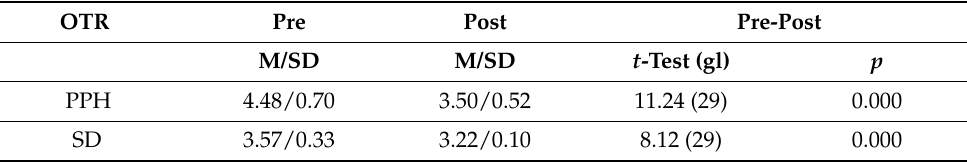
Table 5. The mean (M) and standard deviation (SD) of the OTR from the postpartum hemorrhage and shoulder dystocia scenarios pre- and post-training.